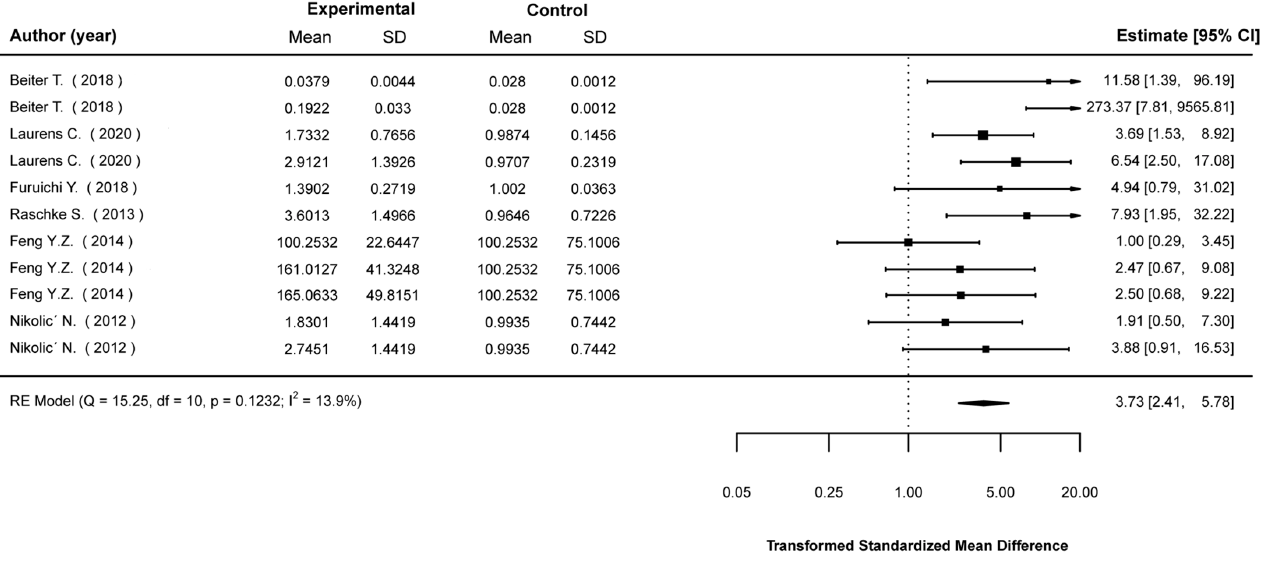
Figure 3. Findings of random-effects meta-analysis on the effects of EPS on AMPK compared to non-stimulated cells. Results shown are transformed standardized mean differences and 95% confidence intervals, as an estimate of the log odds ratio. Differences greater than 1.00 favour the EPS cells compared to non-stimulated control cells [16,19,23,28–31,45,52,53].